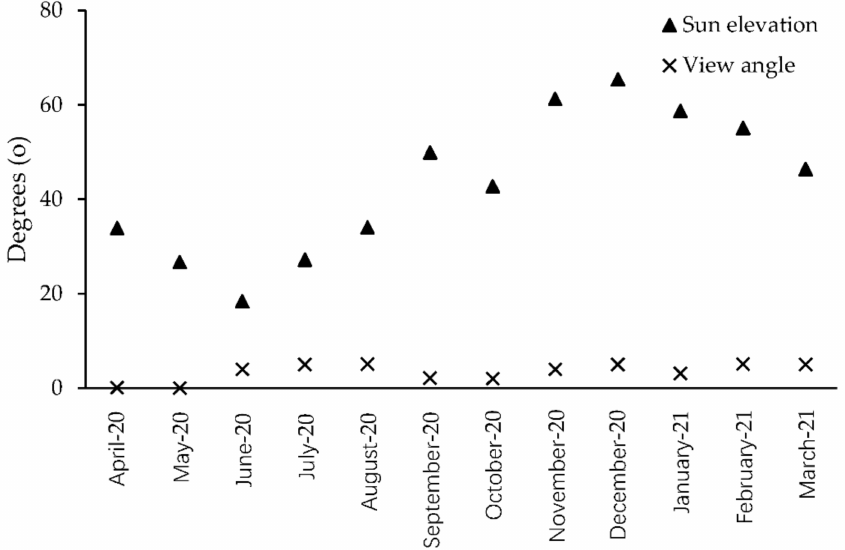
Figure 8. Potential drivers of the NDVI variation measured in saltmarsh: sun elevation and view angle at the time each PlanetScope image was